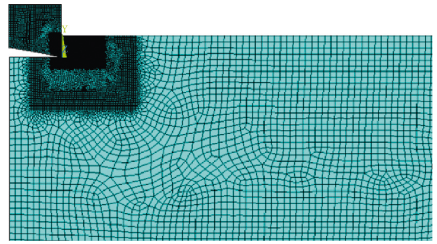
Figure 5: Mesh models of graphite composite orthogonal